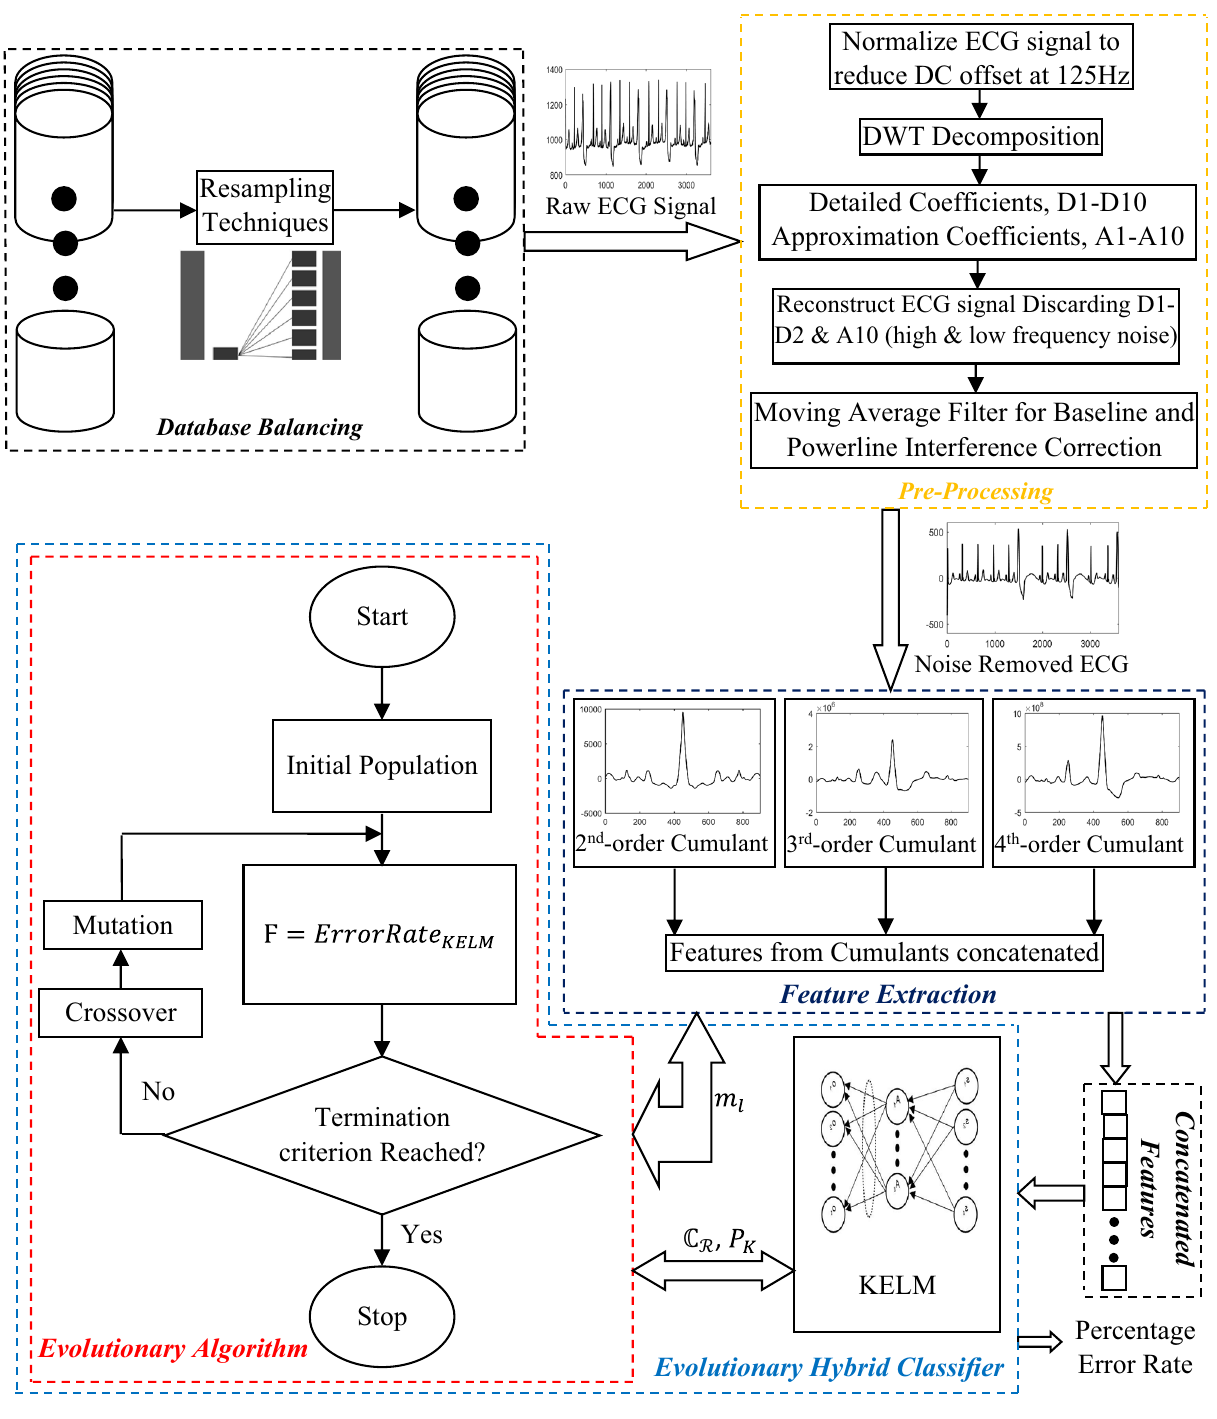
Figure 7. Detailed block diagram of the proposed approach.